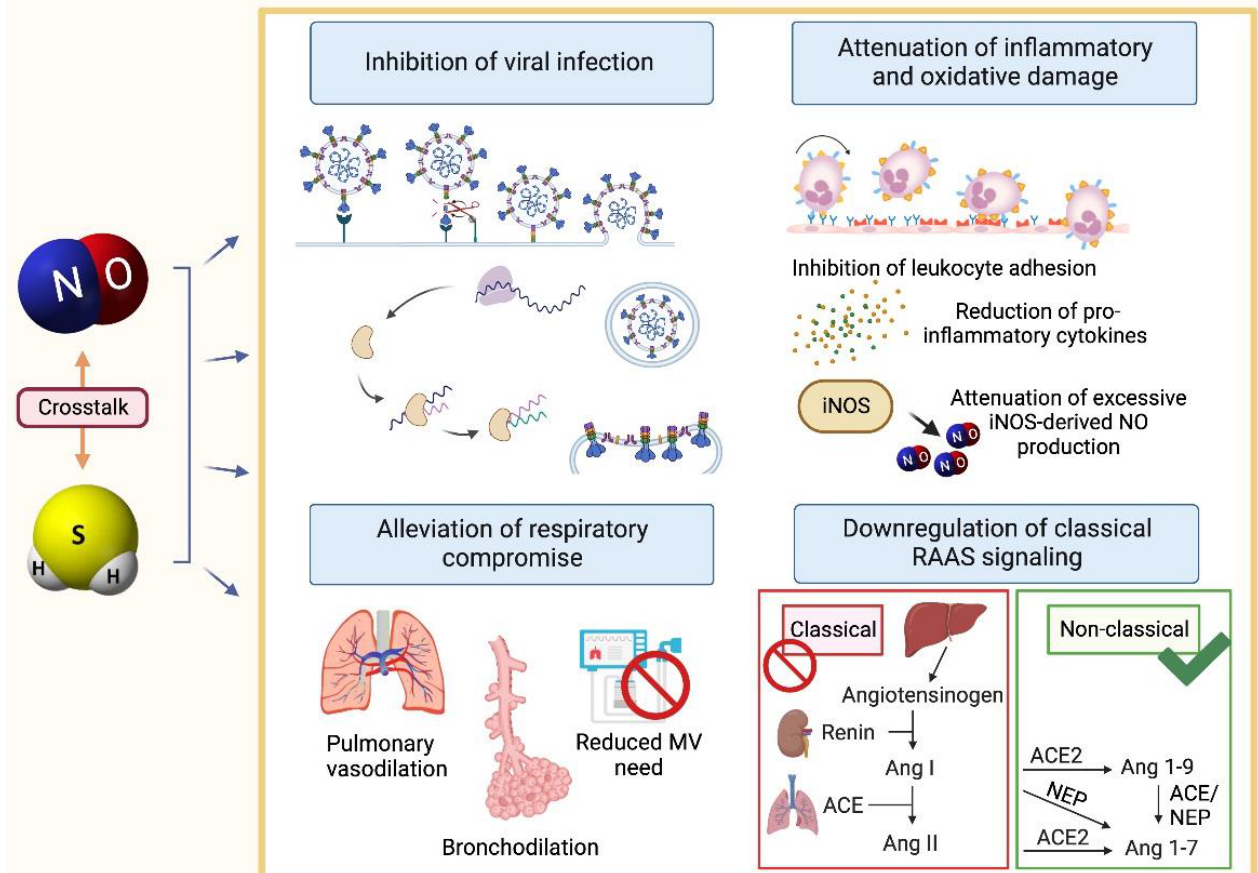
Figure 3 . NO and H 2 S applications in COVID-19. NO and H 2 S are antiviral agents with promise for inhibiting SARS-CoV-2 infection through interference with entry, replication, and release. Both gasotransmitters also have potential applications in later-stage management of COVID-19. NO and H 2 S demonstrate the ability to inhibit leukocyte adhesion to the endothelium, reduce levels of pro-inflammatory cytokines, curtail excessive iNOS activity, and overall reduce inflammatory damage. These properties, combined with their vaso- and bronchodilator actions in the pulmonary system, serve to reduce the need for mechanical ventilation and alleviate respiratory compromise. Additionally, NO and H 2 S downregulate the classical RAAS signaling pathway and its related pro-inflammatory shift by inhibiting Ang II and AT 1 R. As a result, NO and H 2 S may have significant potential in the management of COVID-19, a disease recognized for causing hyperinflammatory conditions and respiratory compromise and for having greater severity where the RAAS is imbalanced.